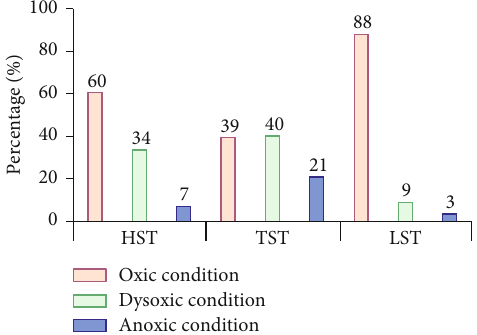
Figure 7: The sequence stratigraphic distribution of U/Th ratios in the Es4u member in the Dongying